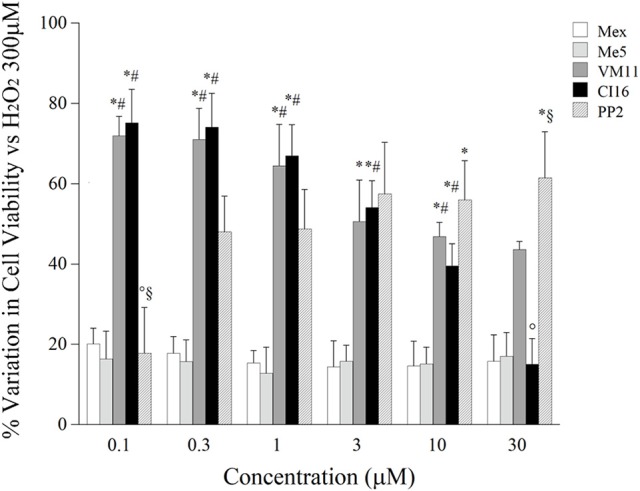
The histograms show the potential cytoprotective effect of increasing concentration of mexiletine, its pyrroline derivatives and PP2 (0.1–30 μM) on cell viability of C2C12 cells. Values are presented as the mean ± S.E.M. and are expressed as the percentage variation of the control according to the following formula: cell viability (%) = [(test value-blank)/(control value-blank)−1] × 100, where the blank value represents that of a cell-free wells, the test value represents that of cells treated either with one of test compounds or H2O2 300 μM and the control value represents that of cells treated with H2O2 300 μM alone. Each data is from at least 12–32 replicates (wells) and 3–8 different culture dishes. All test compounds show a significant cyto-protection with respect to the control value. The statistical significance between groups was found by ANOVA analysis (F > 5; p < 0.03). Bonferroni post-hoc correction for individual differences between groups is as follows: significantly different with respect to *mexiletine (0.0002 < p < 0.008); #Me5 (0.0002 < p < 0.008); ° VM11 (0.001 < p < 0.007) and §CI16 (0.0002 < p < 0.0007).